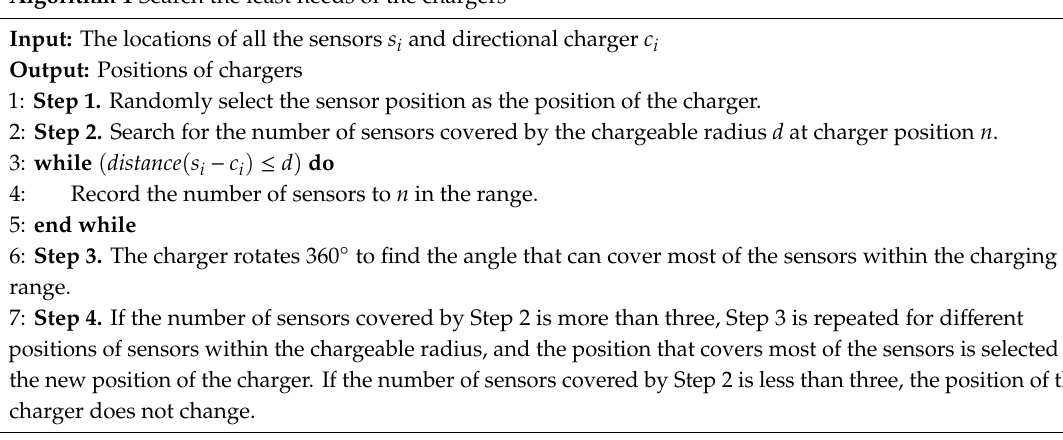
Algorithm 1 Search the least needs of the